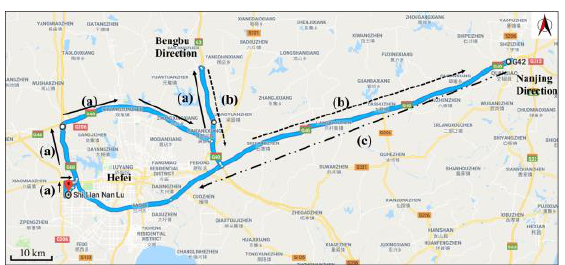
Fig. 3 Schematic chart of navigation path layered on google